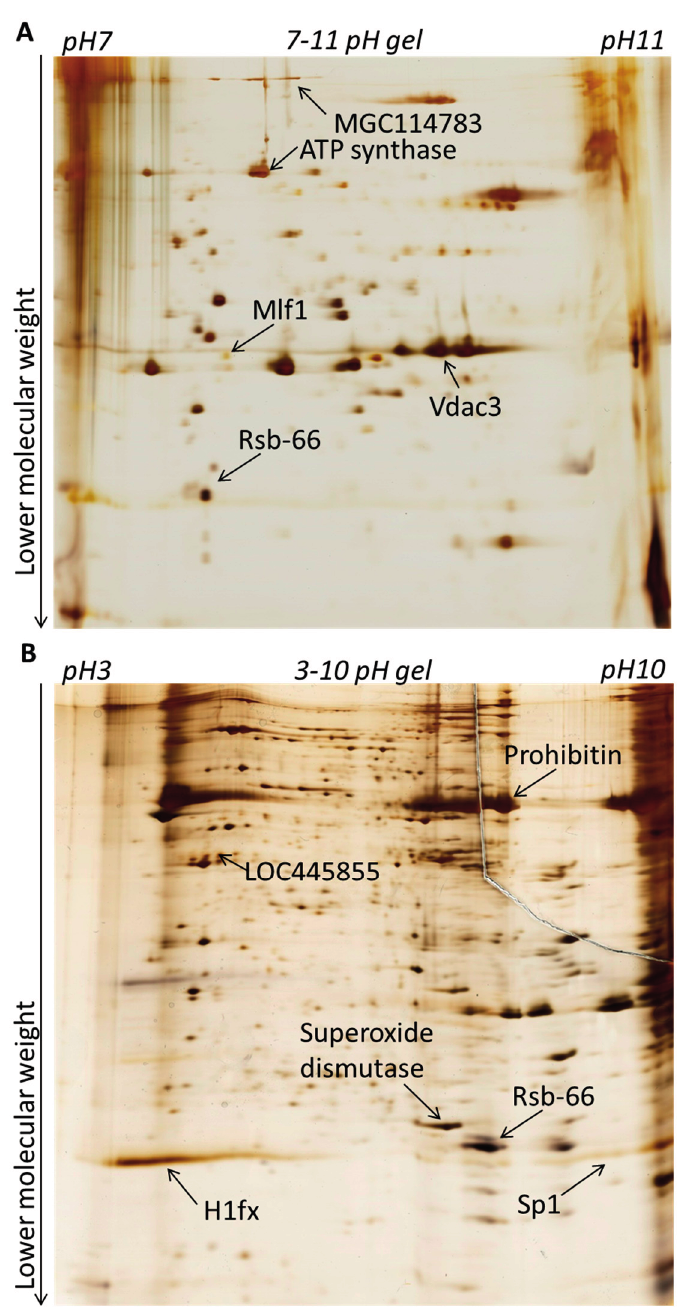
Figure 3. Silver staining of 2D-DIGE gels for spot excision. Gels from Figure 2 were silver-stained to allow protein visualisation and spot excision. Protein examples from Figure 2 are also indicated with arrows. ( A ) proteins separated in pH 7–11; ( B ) proteins separated in pH